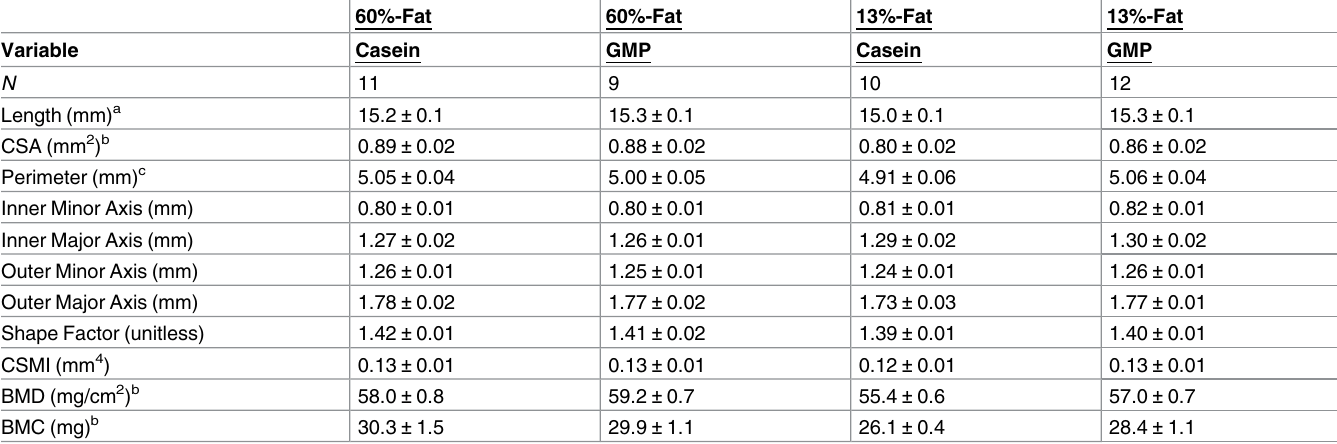
Table 4. Size, shape, and mineral content of mice